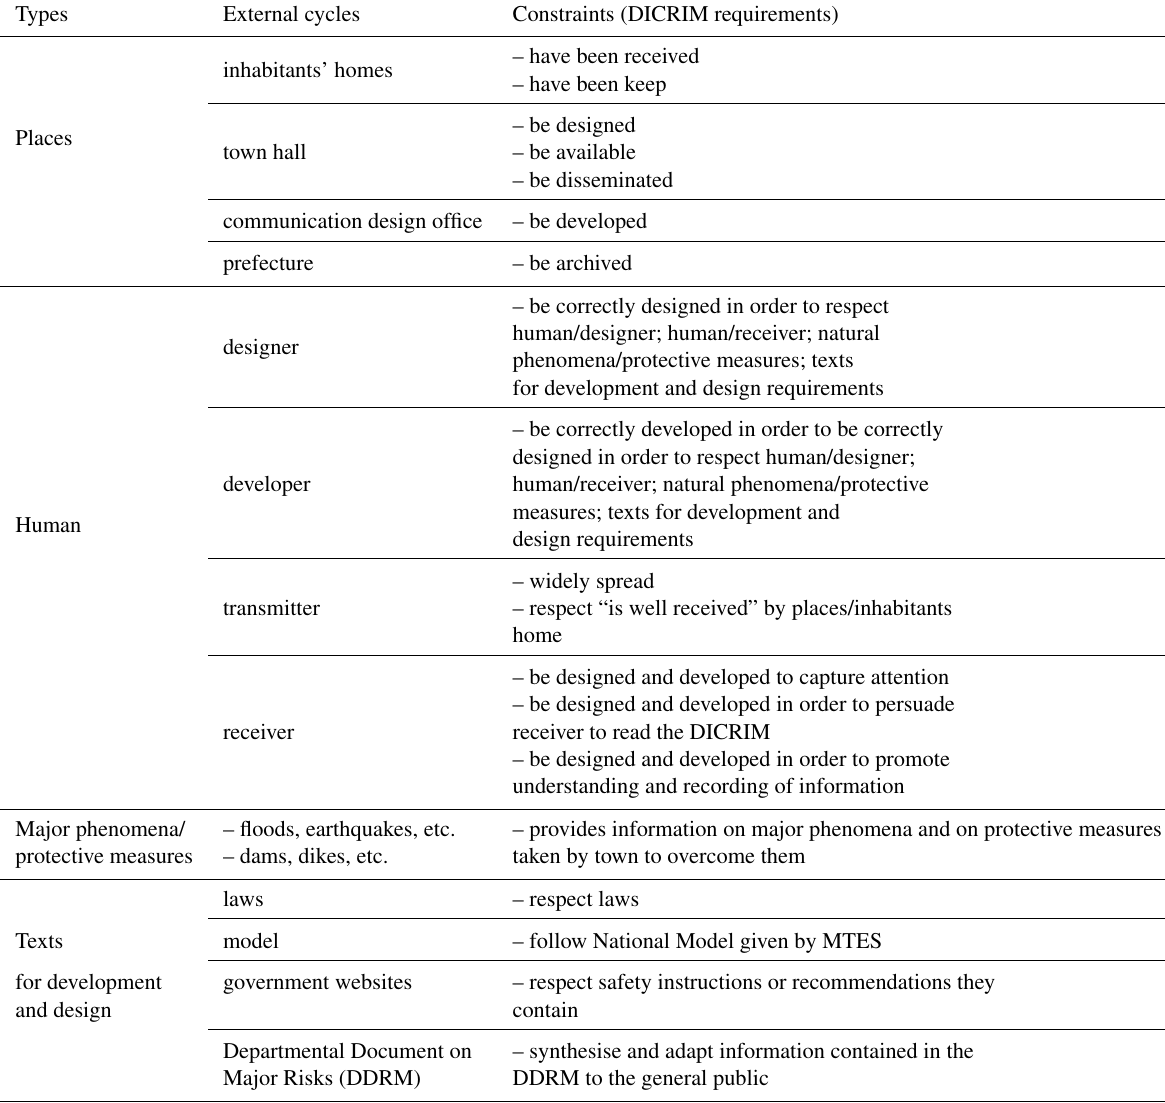
Table 1. Extract of the table showing requirements features highlighted by the interactions between the DICRIM and external circles.